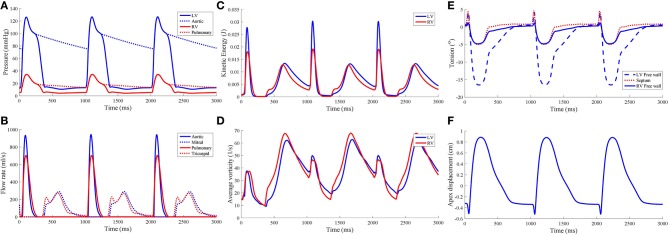
Hemodynamic measures from the standard model, namely (A) pressure waveforms, (B) inlet and outlet flow rates, (C) blood kinetic energy, and (D) average vorticity. Global mechanical measures of ventricular torsion and apex displacement are displayed in (E,F), respectively.